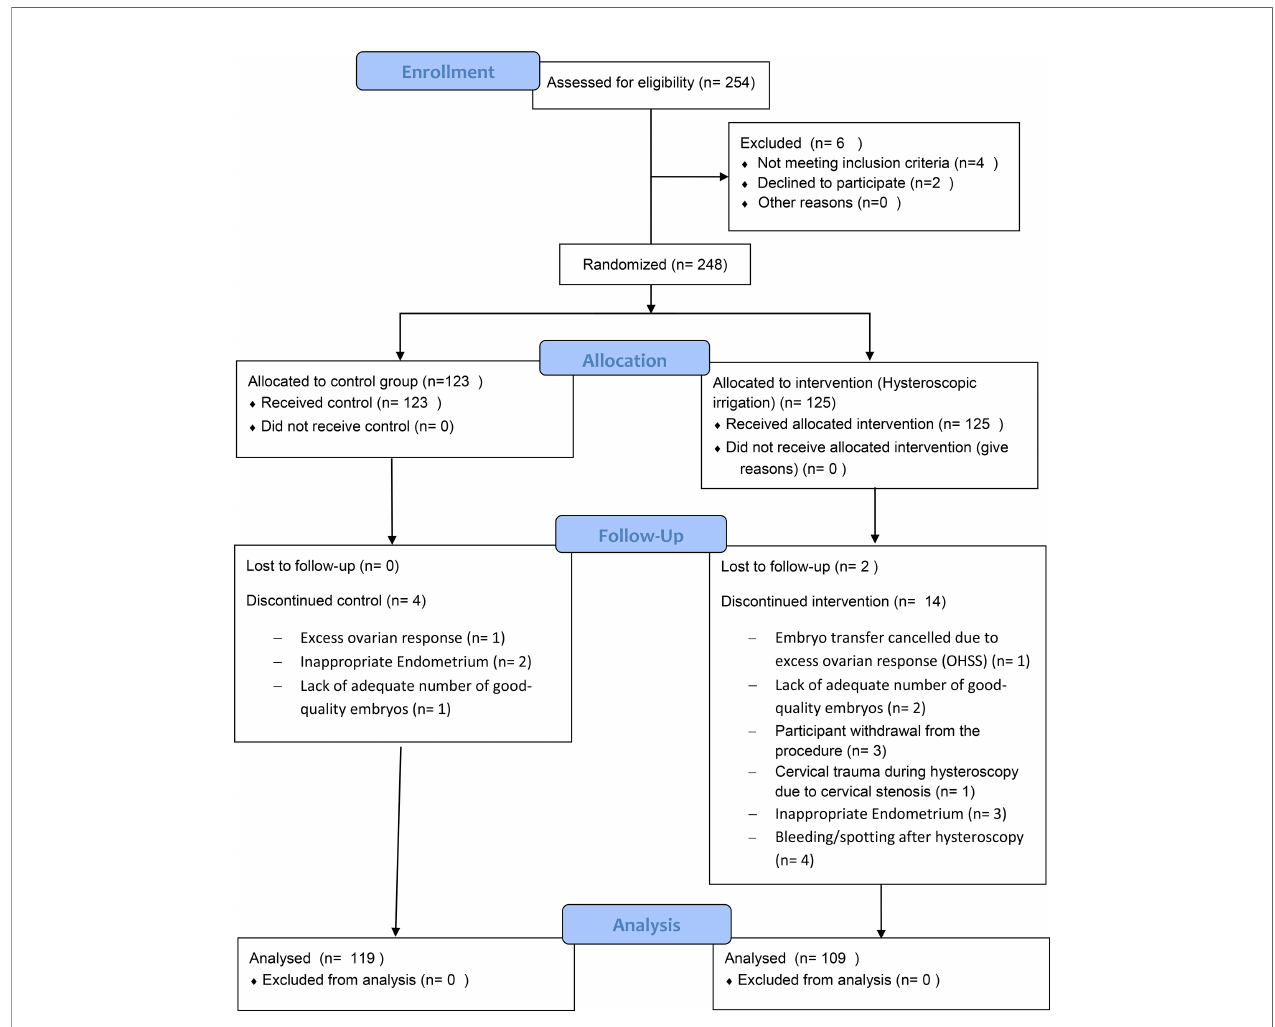
FIGURE 1 | CONSORT fl ow diagram of the